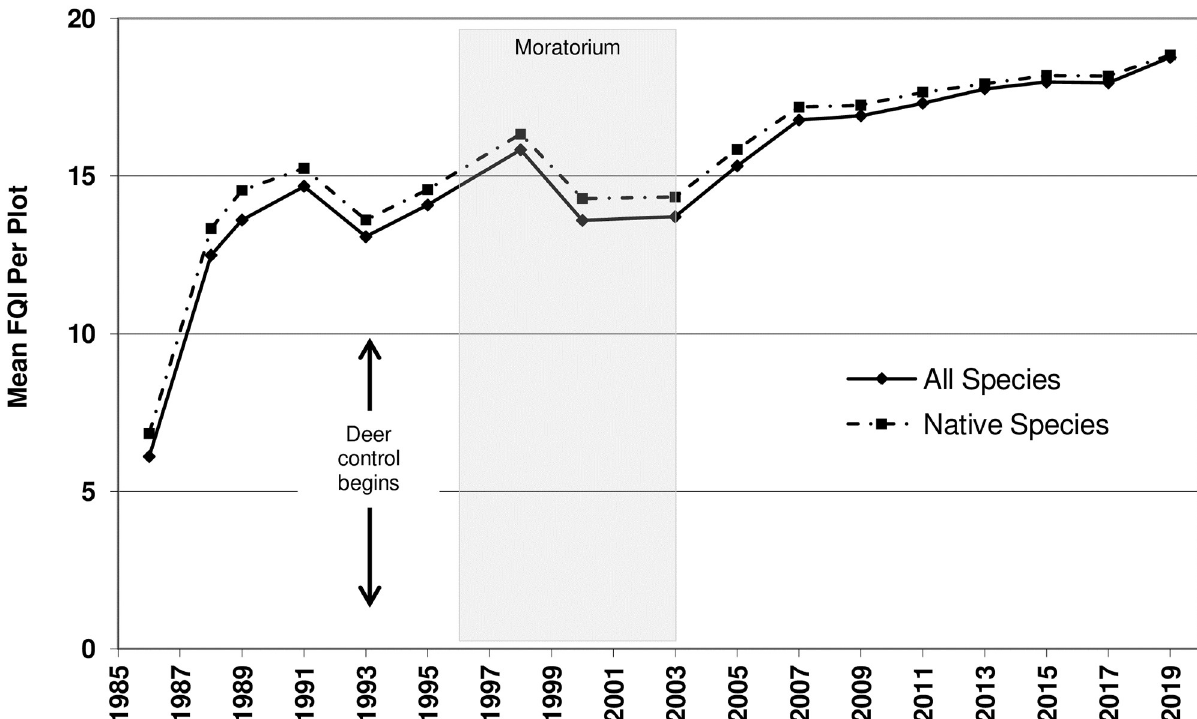
Fig 3. Mean Floristic Quality Index (FQI) per plot. Time series analysis used the mean value of all species for each year sampled. Arrows represent the onset of deer culling, which continued thereafter. Shaded area represents the vegetation management moratorium years.